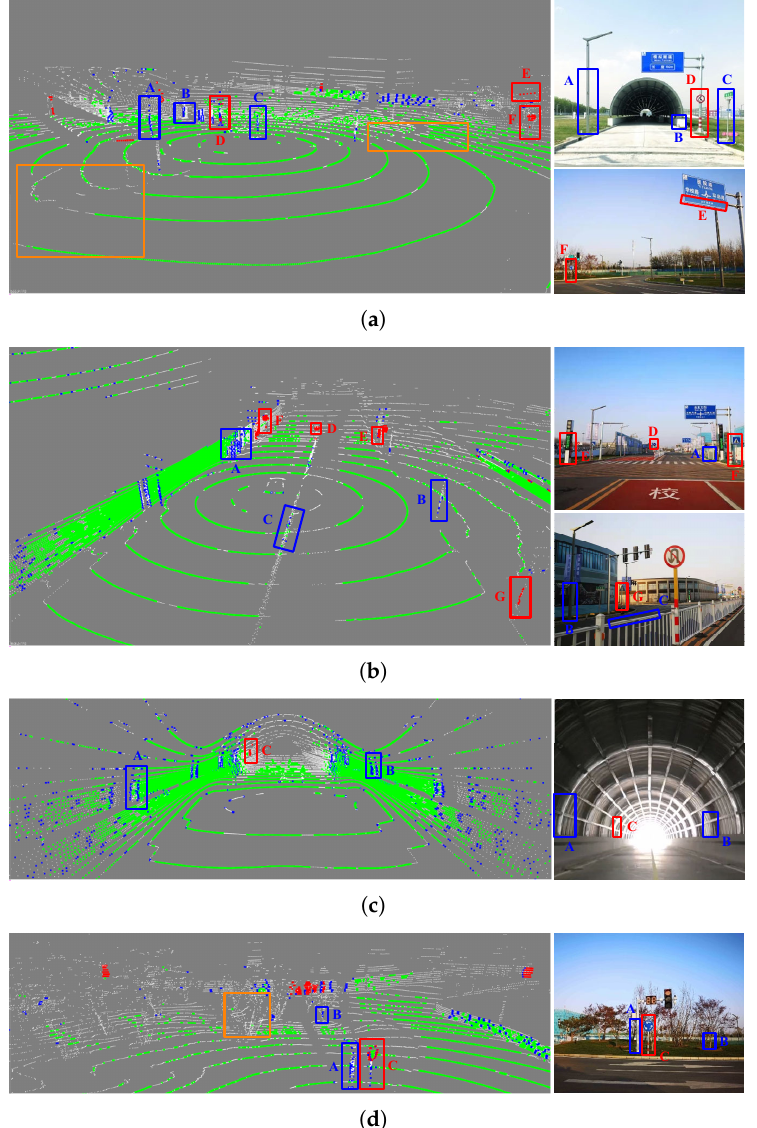
Figure 8. Feature extraction results in different scenes. ( a ) Open road; ( b ) City avenue; ( c ) Long straight tunnel; ( d ) Roadside green belt. (plane, reflector, edge and raw scan points). Objects in the real-world scenes and their counterparts in lazer scans are indicated by boxes (reflector features, edge features, some special